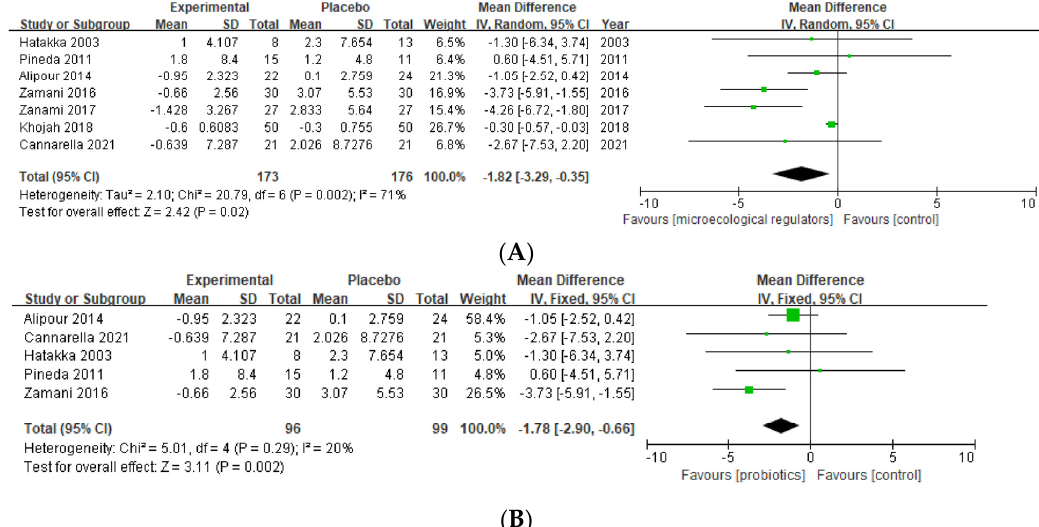
Figure 7. ( A ) Forest plot of CRP variations in rheumatoid arthritis; ( B ) subgroup analysis of probi- otics [36,39,40,42–45].